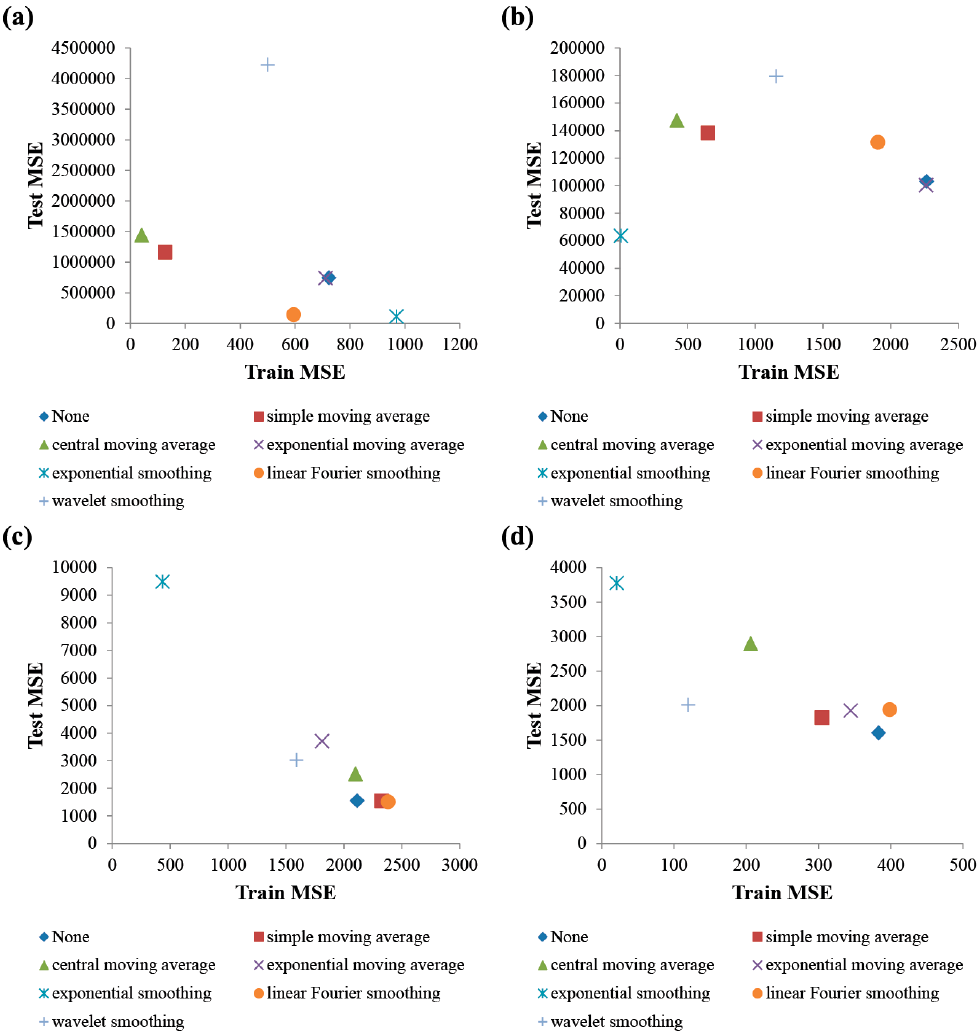
Figure 2. Relations of the training and test MSE values obtained by SF-PCA approaches. ( a , b ) Results of MLP and RF, respectively, over the IEEE 2012 PHM dataset; ( c , d ) Results of MLP and RF, respectively, over the NASA C-MAPSS dataset.